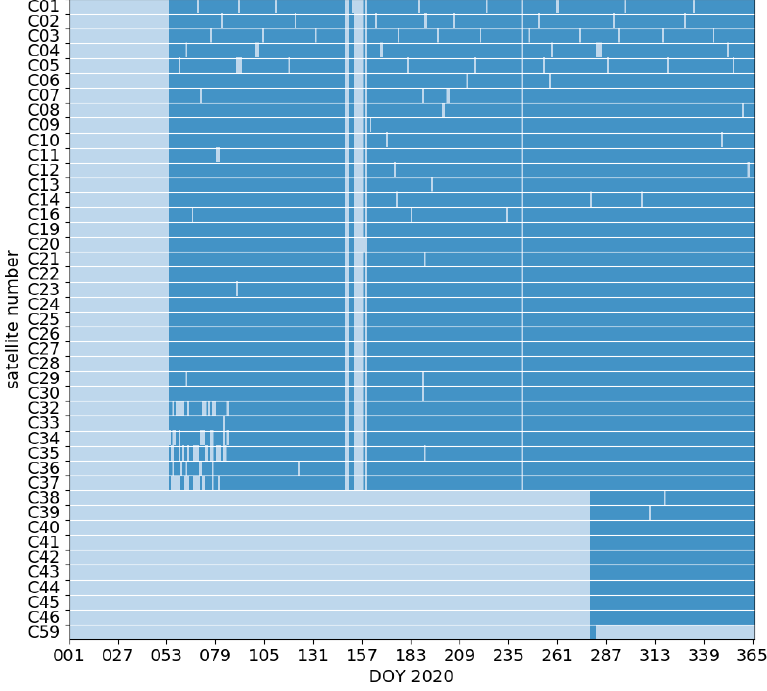
Figure 1. Availability of the BeiDou clock product at the WUM analysis centre in 2020. Days with clock data available are marked dark blue.